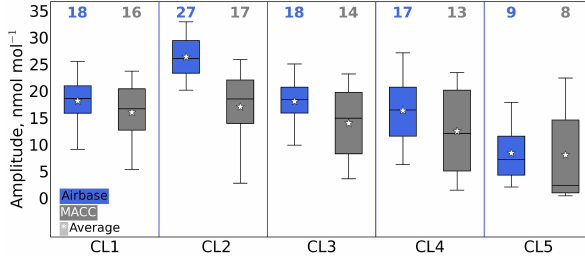
Figure 13. Percentiles (5–25–50–75–95) of ozone diurnal ampli- tudes in clusters; Airbase vs. MACC, first CA. Upper values indi- cate the mean daily amplitude of each cluster.